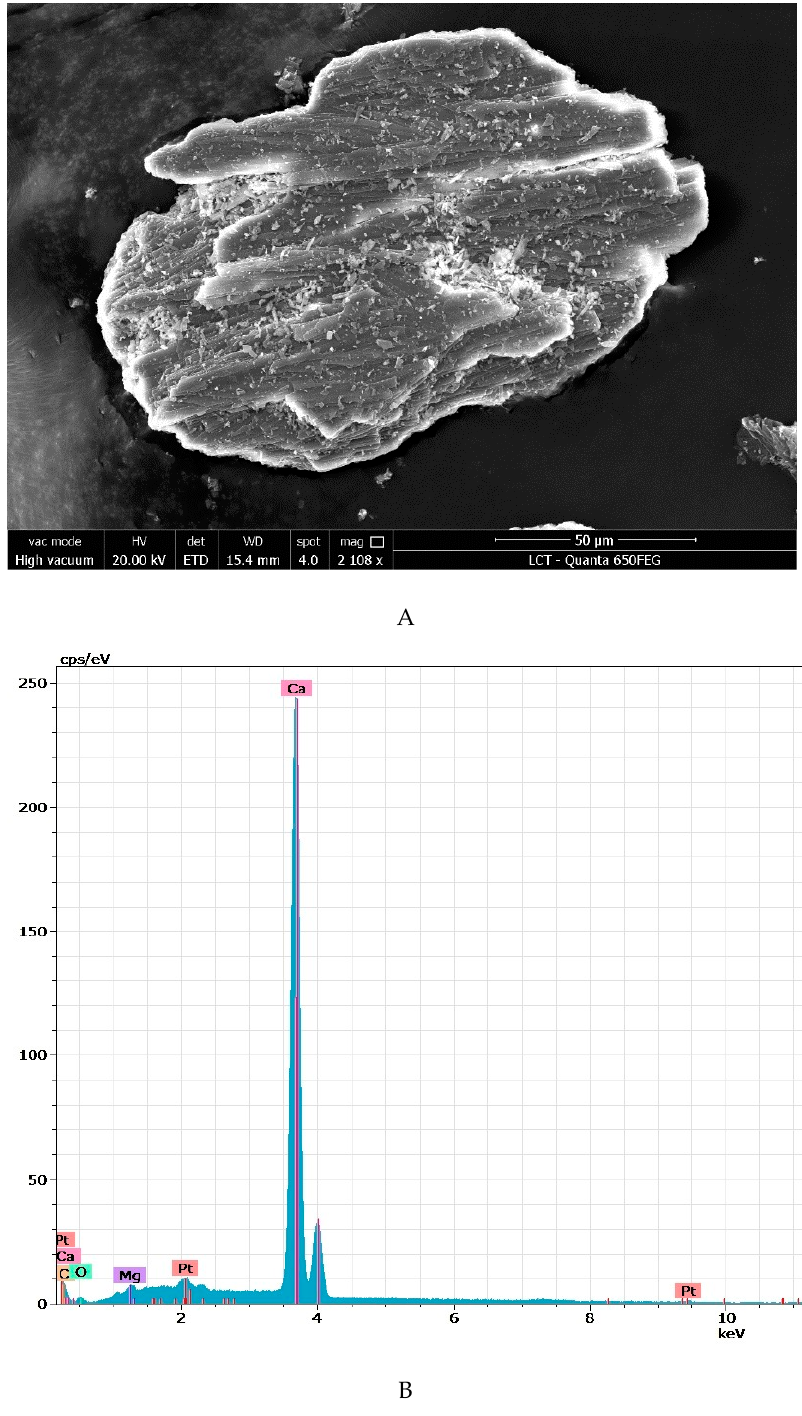
Figure 5. ( A ) Scanning electron microscopy (SEM) images with 2108 × magnification that exhibited a plaque-like morphology with a fibrous appearance for the oyster shell CaCO 3 . ( B ) Energy-dispersive spectroscopy (EDS) analysis: from the information contained in the EDS spectrum it is possible to obtain quantitative information on the sample composition on a microscopic scale. In the spectrum, Platinum (Pt), Carbon (C), Oxygen (O) and Magnesium (Mg) were identified, in addition to Calcium (Ca). X-ray diffractograms (Figure 6) of the three samples show that L. calcareum CaCO 3 contains aragonite (50.3 wt%), magnesian calcite (45.3 wt%) and calcite (4.4 wt%), as